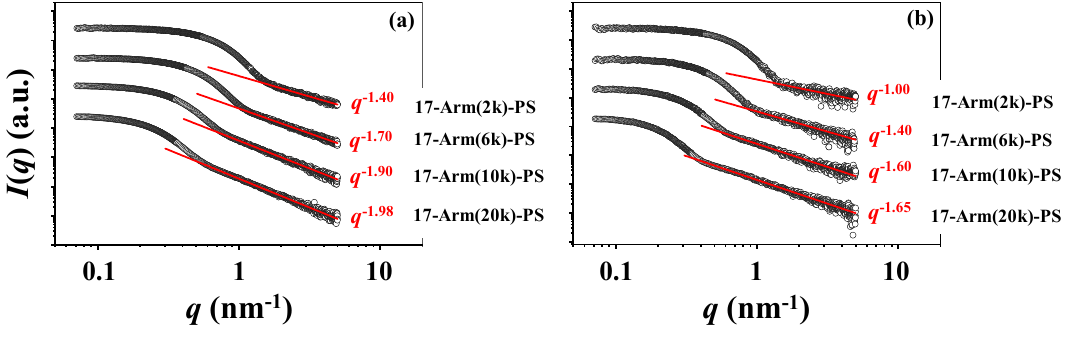
Figure 5. Porod analysis results of the X-ray scattering data in Figure 2 ( a ) CHX at 35.0 ° C ( Θ condition); ( b ) THF at 25.0 ° C.